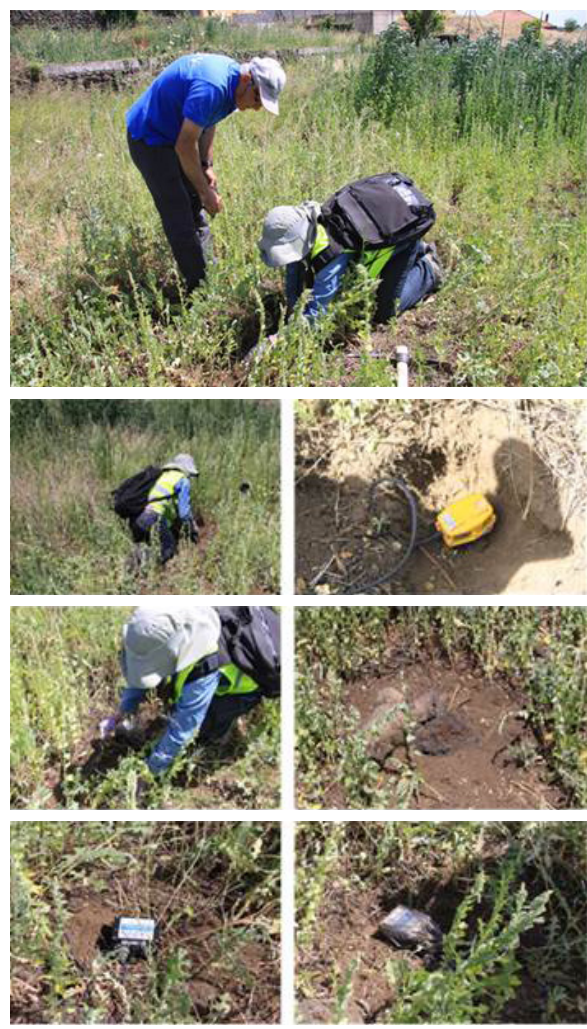
Figure 18. Different stages of the deployment of the seismic sta-